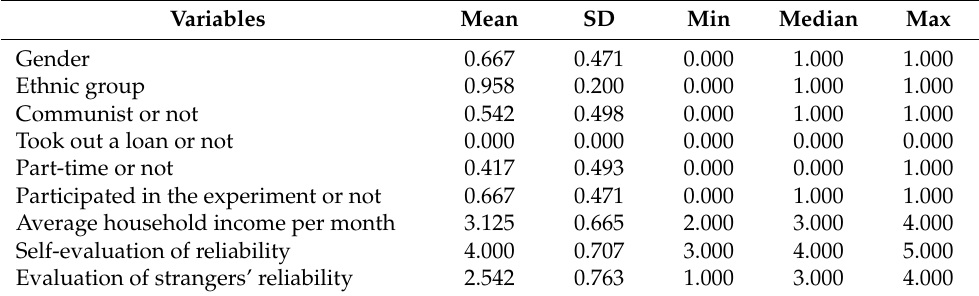
Table 4. Descriptive statistics of subjects’ social and demographic